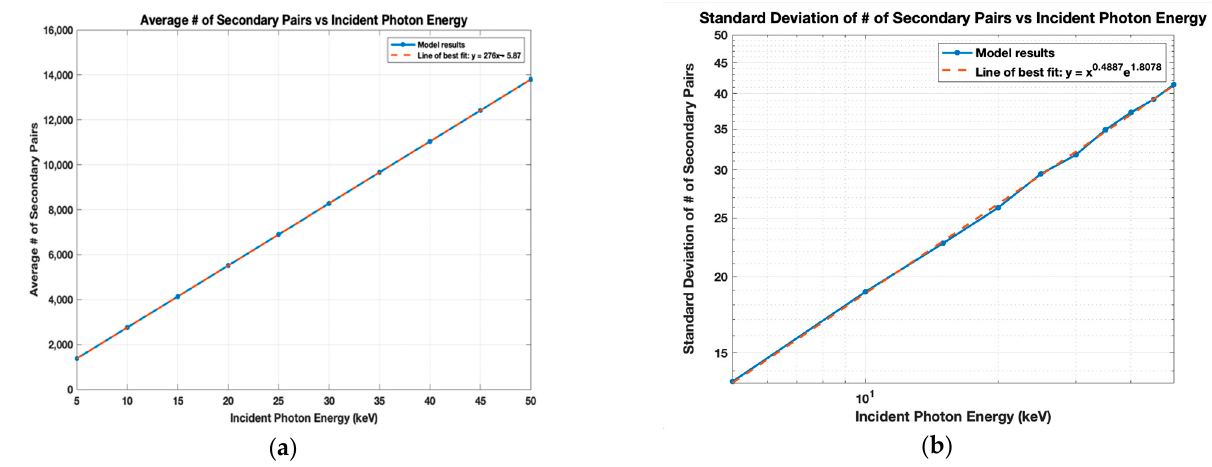
Figure 7. Full model results. ( a ) The average number of secondary pairs created; ( b ) The standard deviation of the number of pairs. The best fit and model values have a standard deviation of less than 1%.